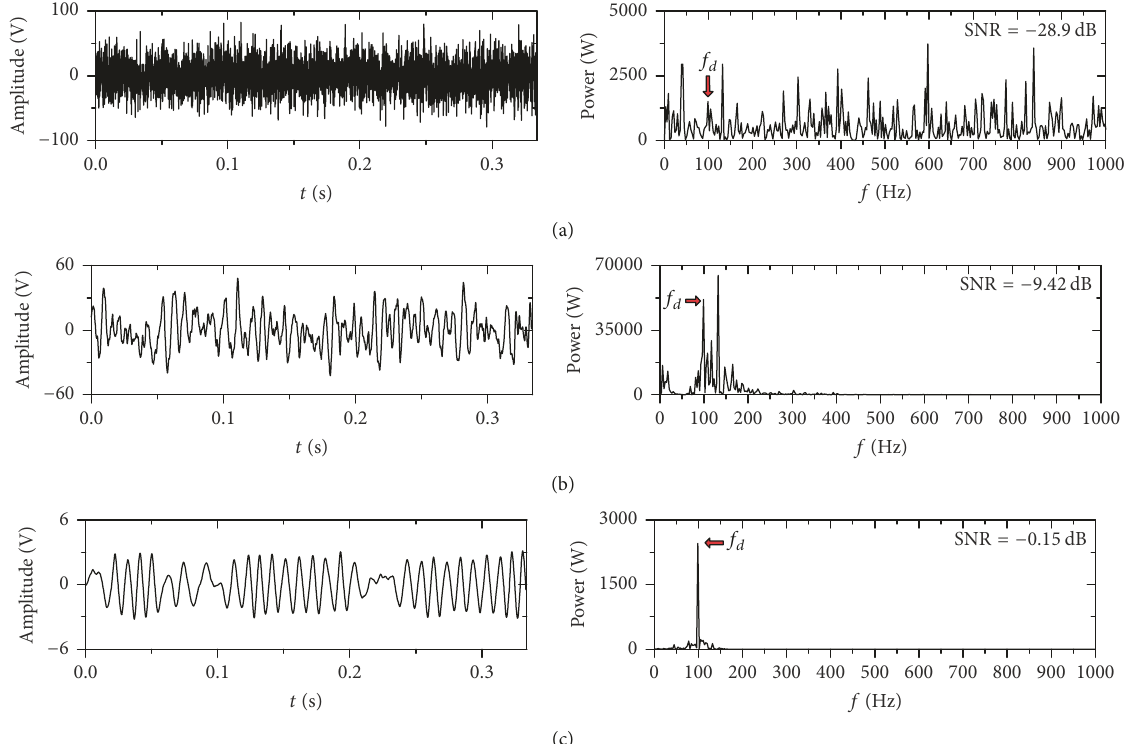
Figure 4: Comparison of the periodicity and noise suppression performance of two WSD methods: (a) input signal; (b) MSTSR output signal (optimal parameters: 𝑎 = 0.7 , 𝑏 = 8𝑒 − 4 , ℎ = 0.01 , and 𝐾 = 6 ); and (c) optimal SVVR output signal (optimal parameters: 𝑎 = 1.9 , 𝑏 = 2.9 , 𝛾 = 0.009 , ℎ = 0.015 , 𝐵 = 1.6 , and Ω = 23236